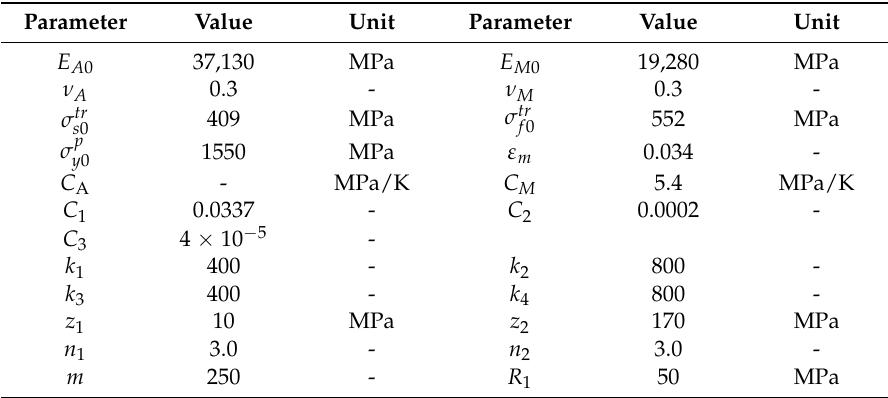
Table 3. Material parameters of NiTi alloys under compressive